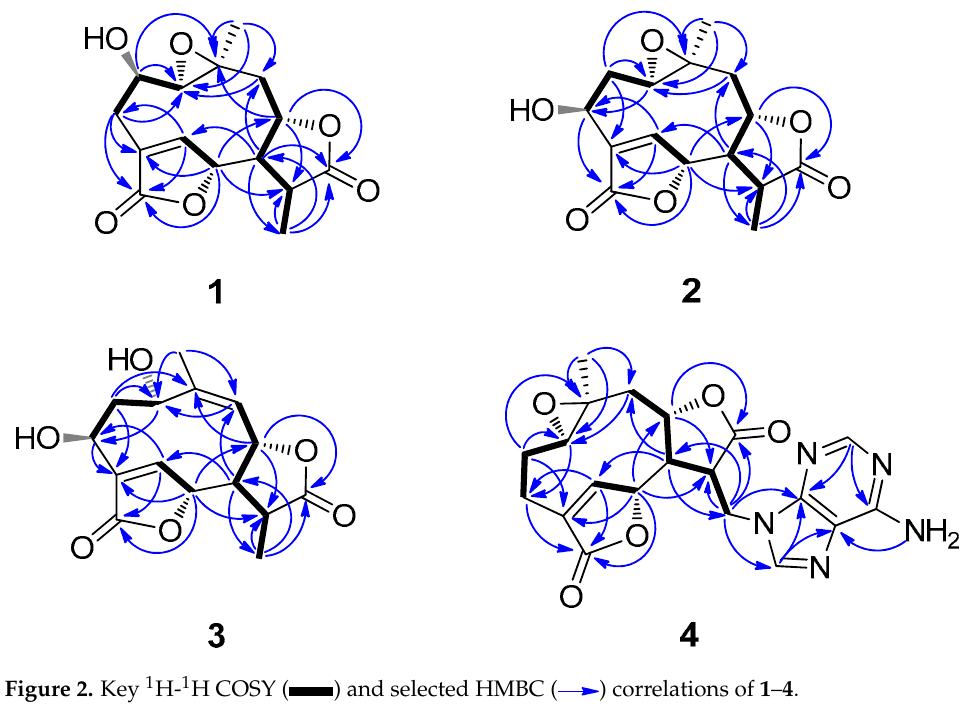
Figure 2. Key 1 H- 1 H COSY ( ) and selected HMBC ( ) correlations of 1 − 4 .